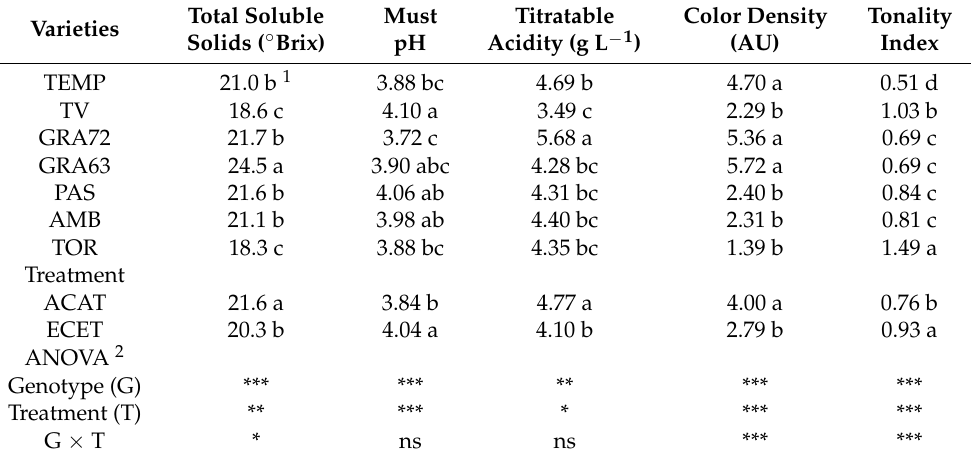
1 Values represent means. Within columns, means followed by the same letter do not differ significantly ( p ≥ 0.05) according to Duncan’s test as affected by the main factors genotype (G) (n = 8–12), treatment (T) (n = 34) and their interaction (G × T). 2 Significance of the analysis of variance (ANOVA): * p < 0.05; ** p < 0.01; *** p < 0.001; ns, not significant ( p ≥ 0.05). AU indicates absorbance units. Table 4. Phenolic composition and antioxidant capacity from fruit-bearing cuttings of genotypes from seven local old grapevine varieties recovered in Navarre (Spain) grown under two climate scenarios during berry ripening: (1) ambient CO 2 (400 ppm) and ambient temperature (T) (ACAT) and (2) elevated CO 2 (700 ppm) and elevated temperature (T + 4 ◦ C) (ECET). Genotype labels can be found in Table 5.